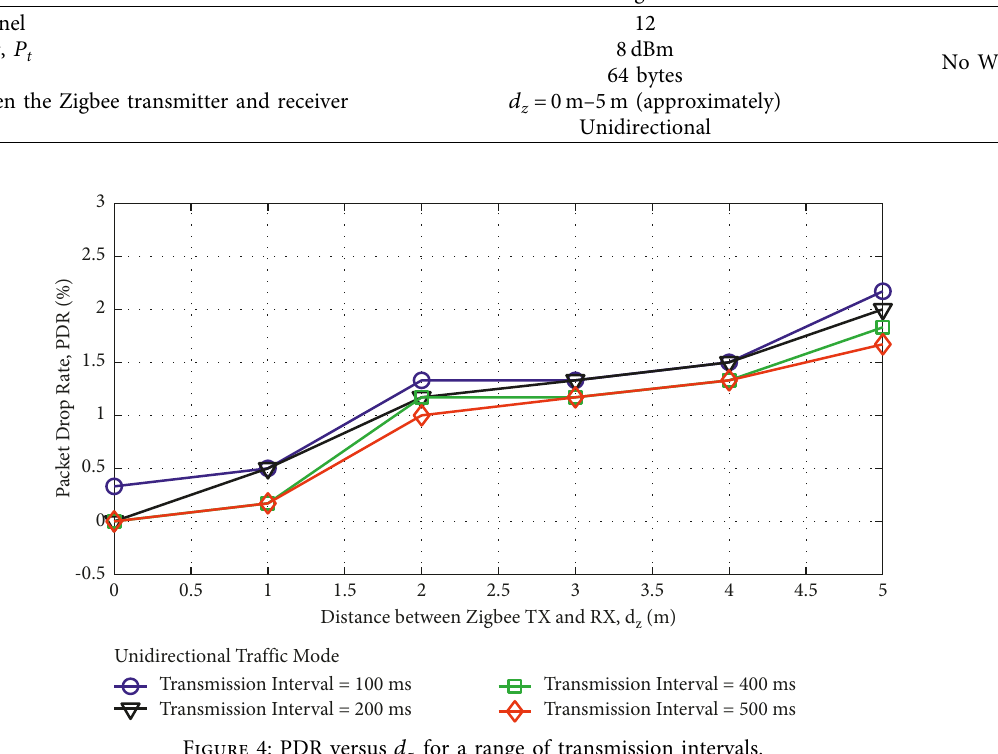
Figure 4: PDR versus d z for a range of transmission intervals.